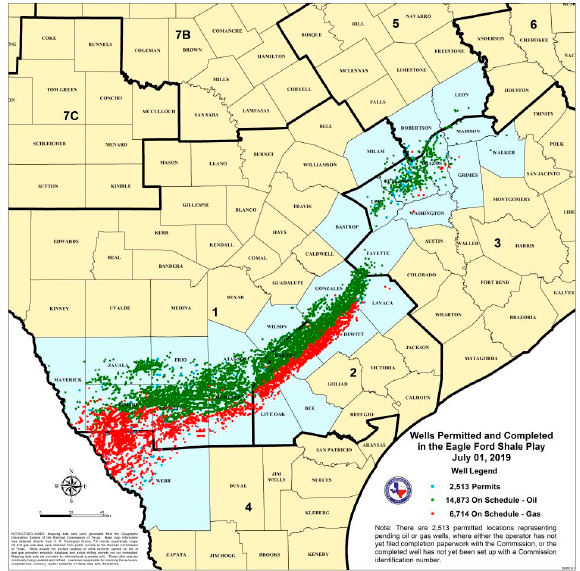
Figure 3. Wells permitted and completed in the Eagle Ford shale [27].